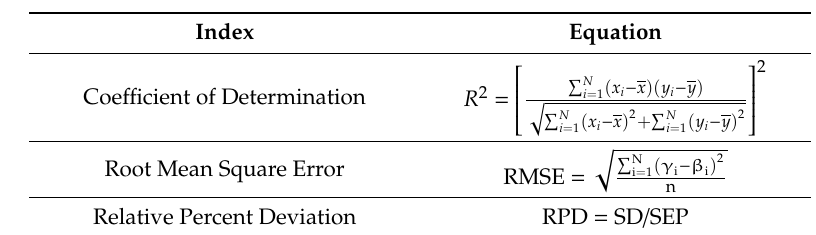
Table 3. Model evaluation index.